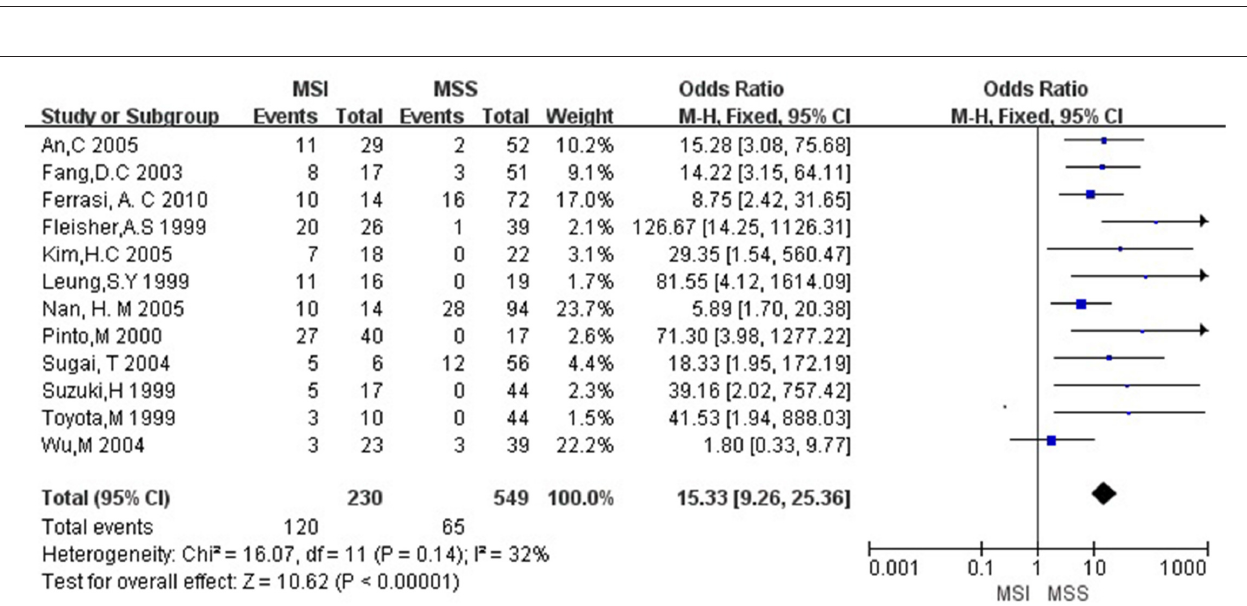
FIGURE 3 | Forest plot concerning hMLH1 methylation and lymph node metastasis. Fixed-effect model was used.